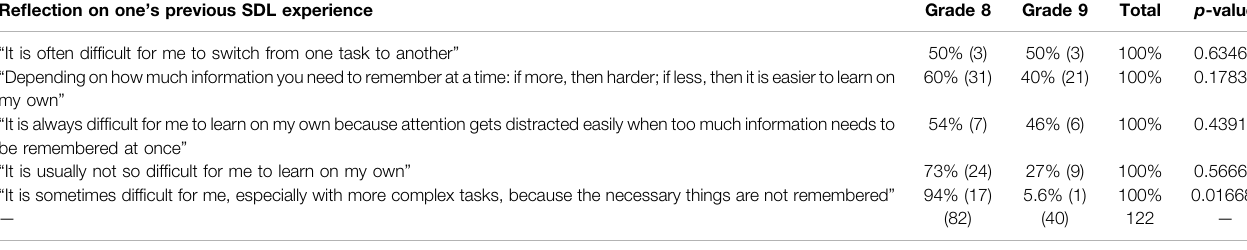
TABLE 7 | Subcategories ’ distribution of the question “ how do you usually feel about learning on your own? ” by grades. Re fl ection on one ’ s previous SDL